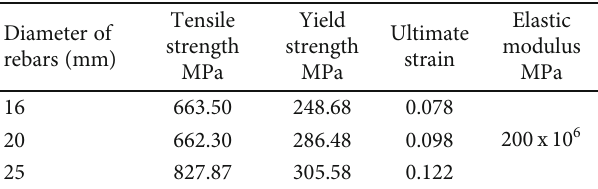
Table 3: Properties of the control-reinforcing